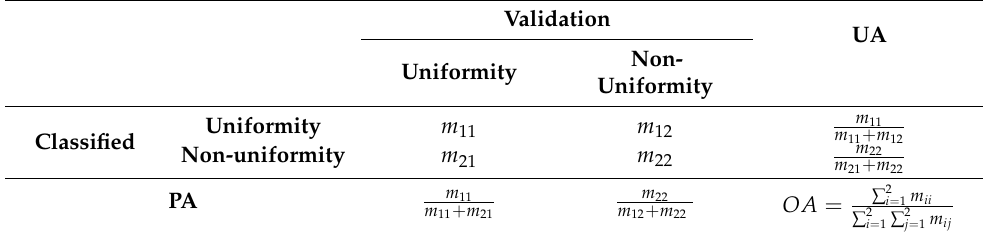
Table 2. Confusion matrix for hyperparameter setting.